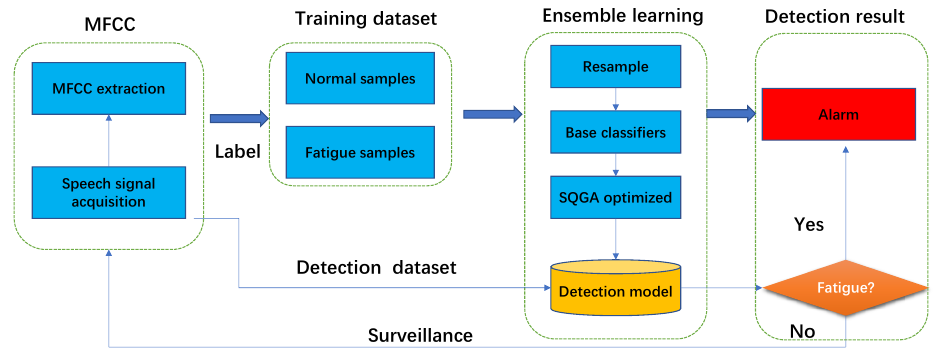
Figure 7. The flow chart of fatigue detection.